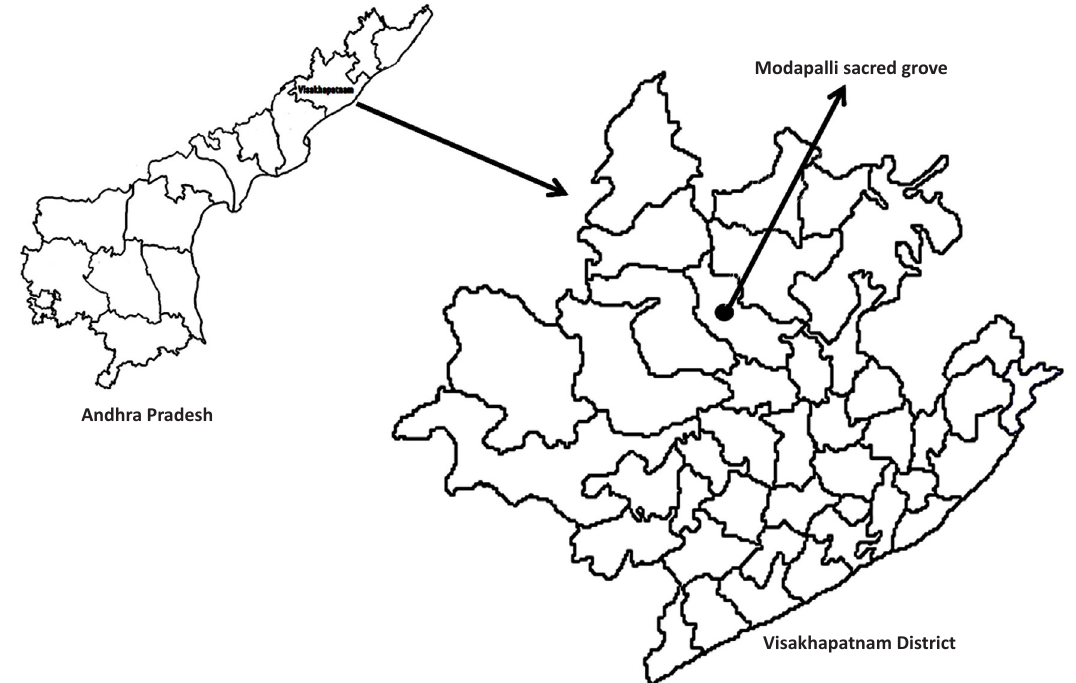
Figure 1. Map showing relative location of the Modapalli sacred